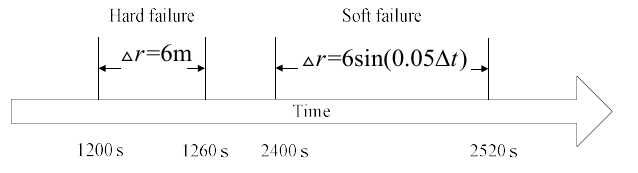
Figure 10. Failure timing sequence.